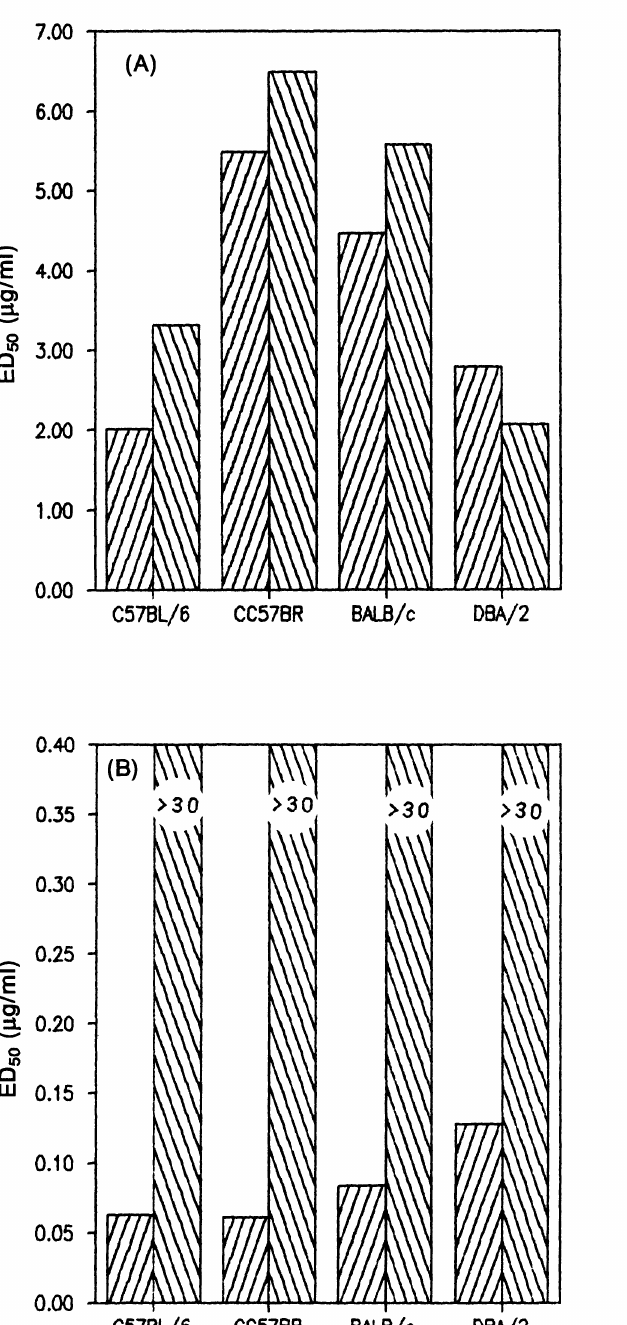
FIG. 2. Mf (A) and CsA (B) action on the proliferative response of Con A-stimulated freshly isolated spleen cells or IL-2-stimulated 7-day CTL culture. [], spleen cells; N-x], cytotoxic